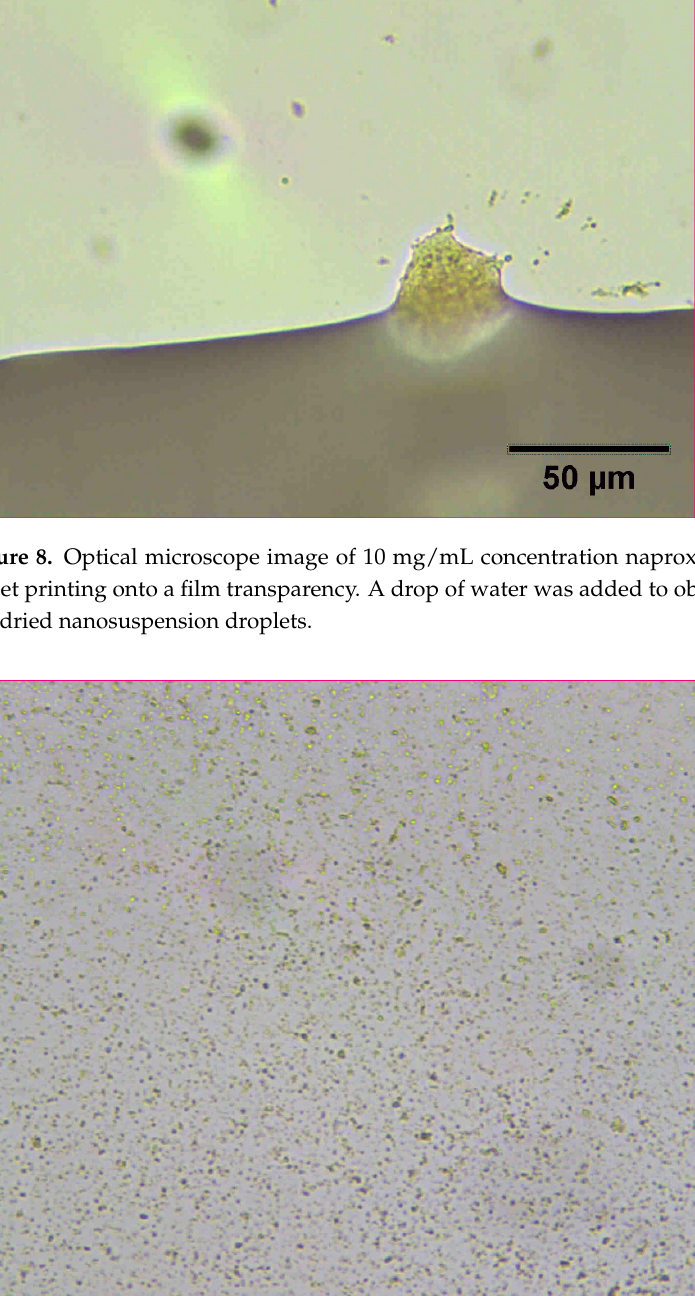
Figure 9. Optical microscope image of 10 mg/mL concentration naproxen nanosuspension after reconstitution with water.